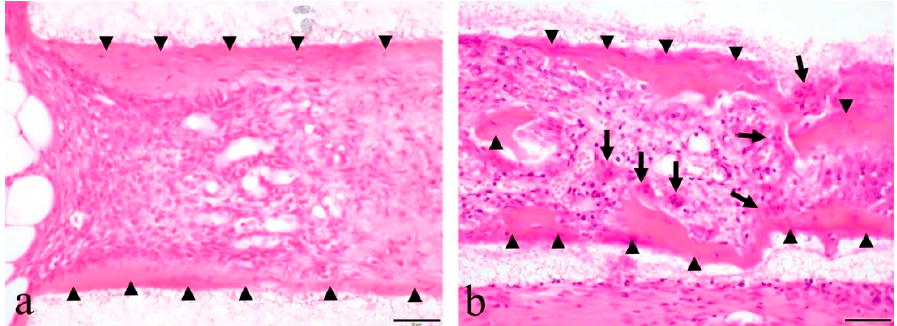
Figure 2. Histological images of formed hard tissues. ( a ) Hard tissue in the experimental group. ( b ) Hard tissue in the control group. Arrowhead: Bone-like hard tissue, Arrow: Multinucleated giant cell. The scale bar indicates 50 μ m.